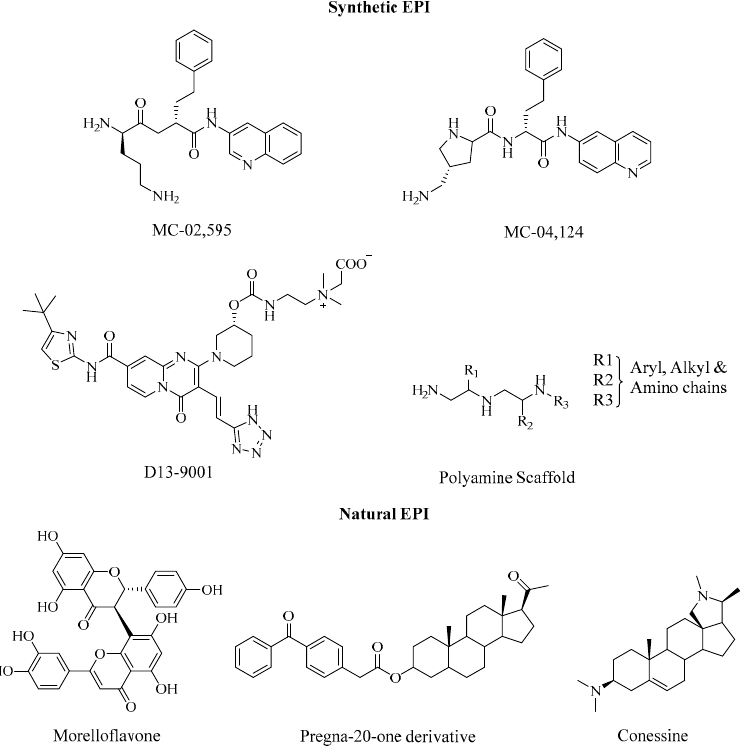
Figure 7. EPIs directed against Mex efflux pumps in P. aeruginosa.